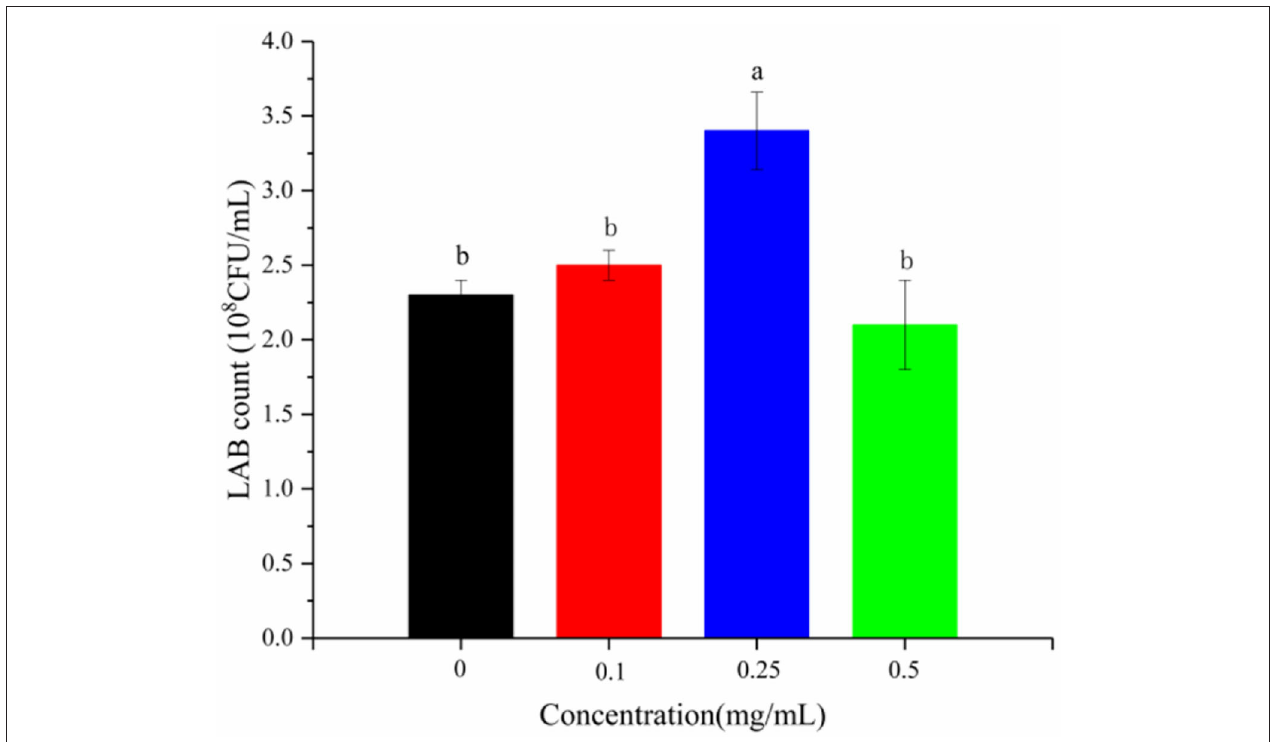
FIGURE 2 | Content of LAB in yogurt with different concentrations of procyanidin. Different letters indicated significant differences ( P < 0.05).